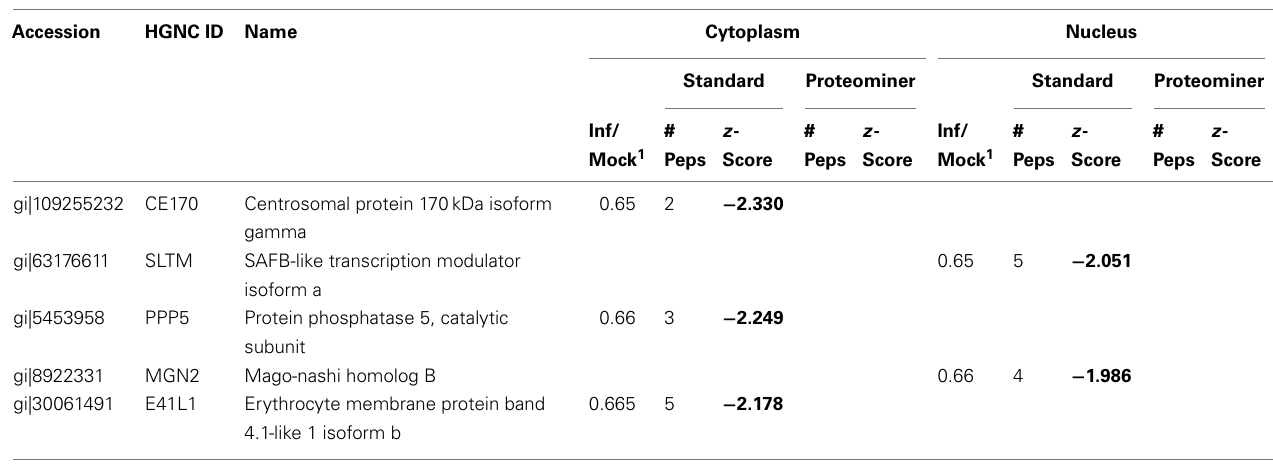
1 Weighted H:L ratios, scaled to number of measured peptides in each sample, if detected in both Standard and Proteominer samples. 2 Bolding indicates a significant z-score (95% confidence), either > 1.960 or < –1.960. 3 Gene removed from NCBI database.